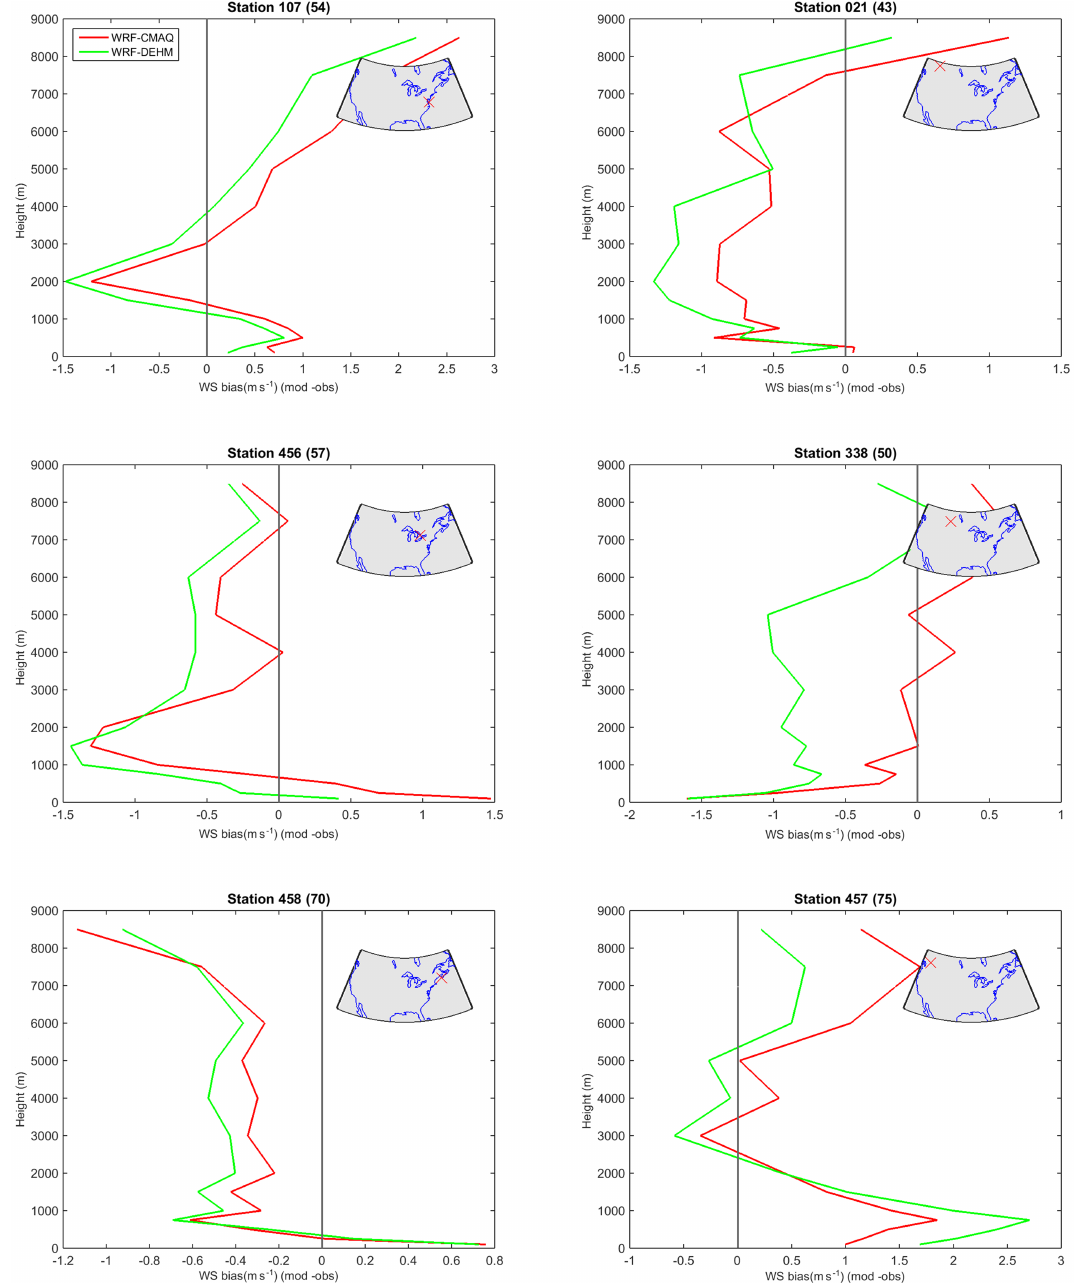
Figure 6. Mean bias (model–observations) for the vertical profiles of wind speed measured by ozonesondes launched from the North Amer- ican locations indicated in the inset map of each panel. The number of hourly profiles available for each site is reported in parentheses at the top of each